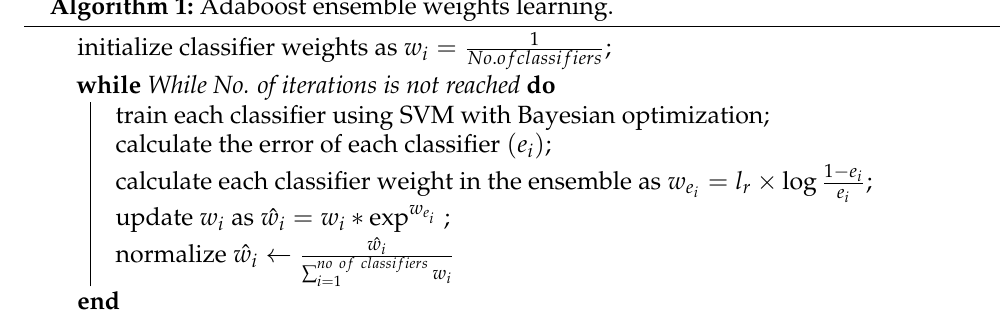
Algorithm 1: Adaboost ensemble weights